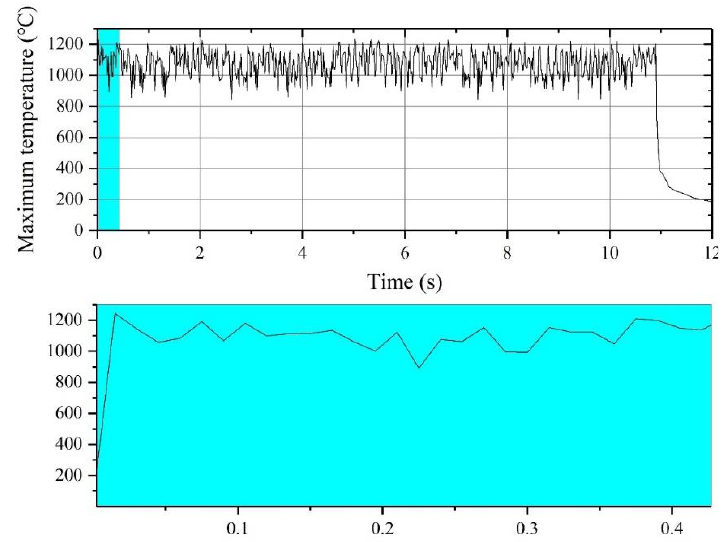
Figure 7. Temperature profile on the cut path at 1 s of W18Cr4V cutting.